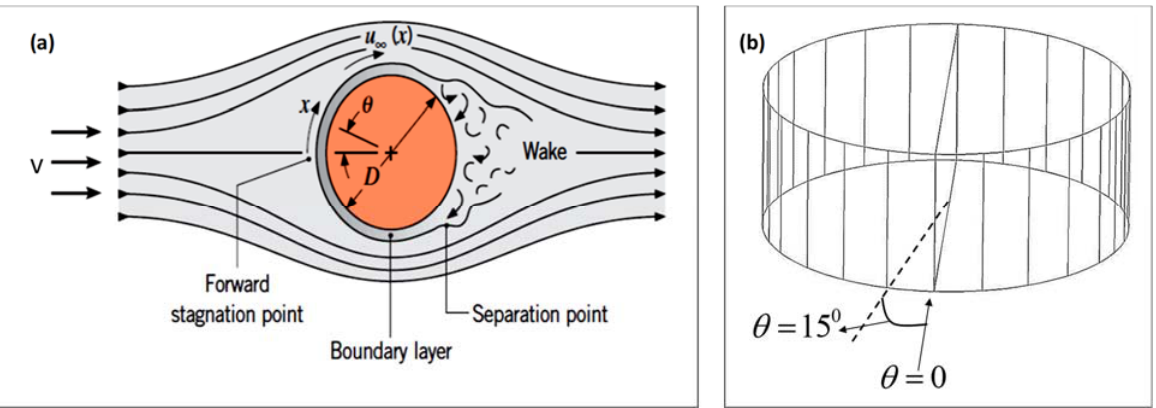
Figure 3. Fluid flow across a cylindrical product: ( a ) fluid flow stream with their boundary layer formation [33]; ( b ) angular positions to calculate the local heat transfer coefficient [32].